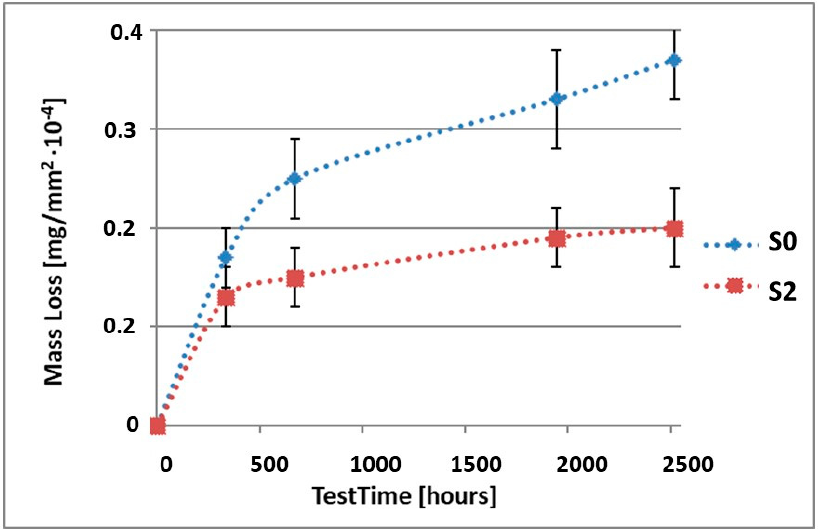
Figure 2. Comparison of the mass losses of samples S0 and S2 for tests in NSS